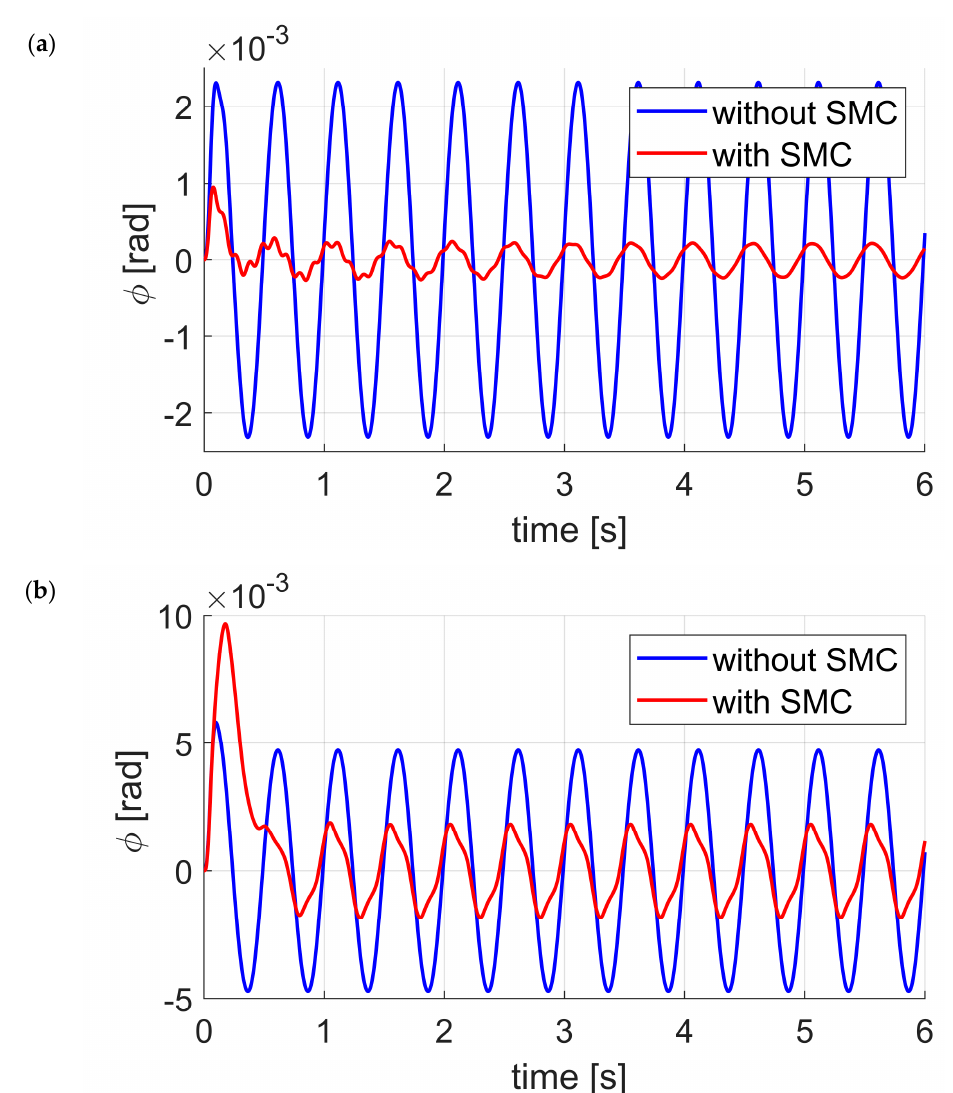
Figure 7. Time courses of variable ϕ for amplitudes A w _ jR = A w _ jL = 0.03 m ( a ), A w _ jR = A w _ jL = 0.06 m ( b ).